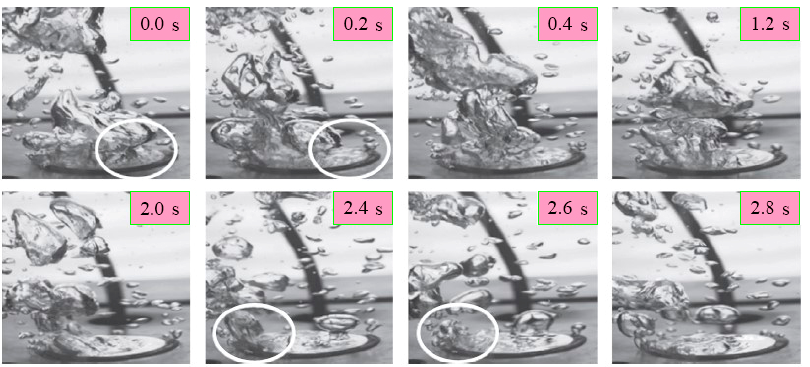
Figure 20. Demonstration of interfacial lift-o ff in pool boiling process for pentane at ∆ T sat = 20 ◦ C and P g = 150 kPa. Reproduced from [271], Elsevier: